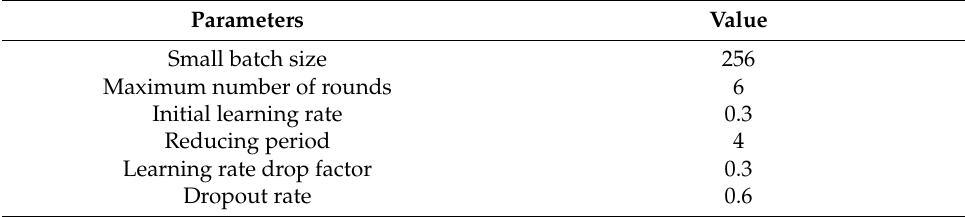
Table 2. Network training parameters.